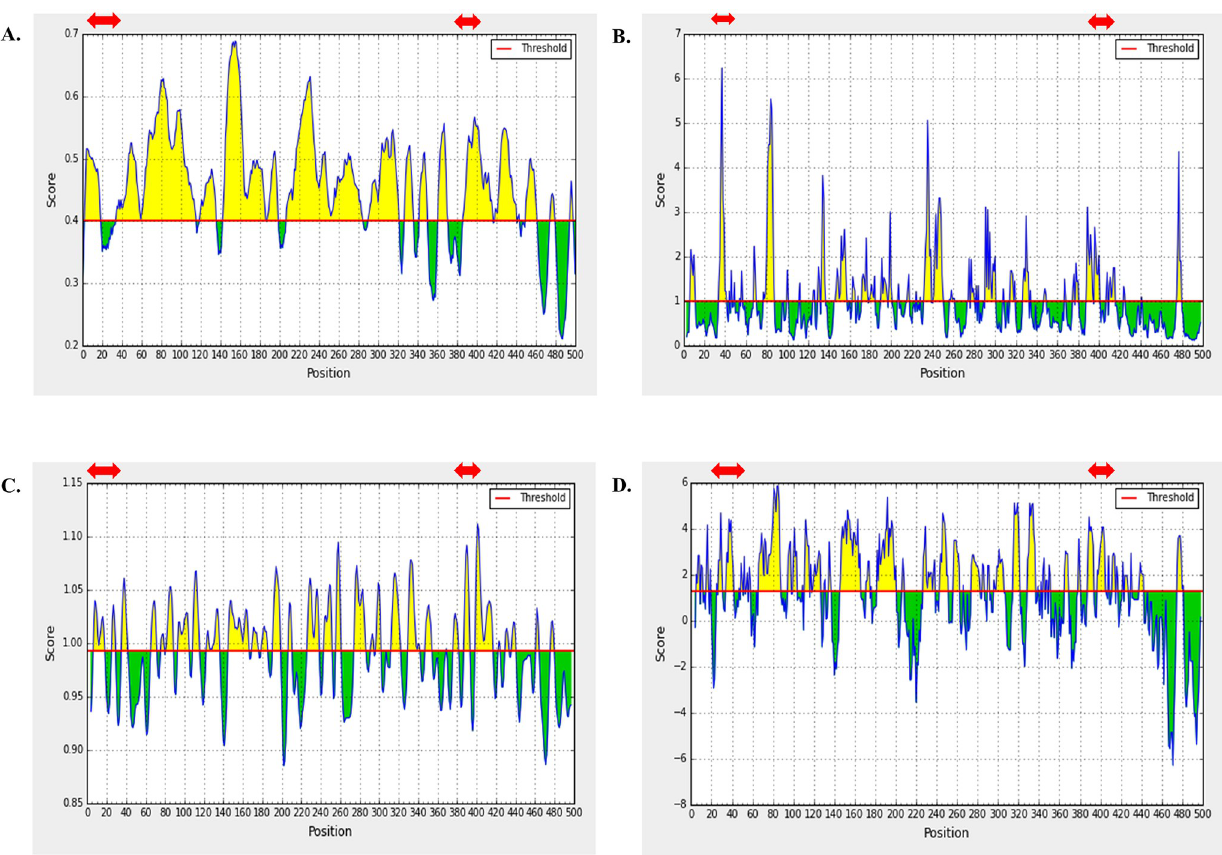
Fig 3. B cell Epitope prediction of Envelope protein at IEDB linear epitope prediction tool. Predicted peptide region above the threshold values (yellow region) are shown in red arrow. Methods used for prediction are enlisted as: (A) BepiPred 2.0, (B) Emini Surface Accessibility tool, (C) Karplus & Schulz Flexibility tool, and (D) Parker Hydrophilicity